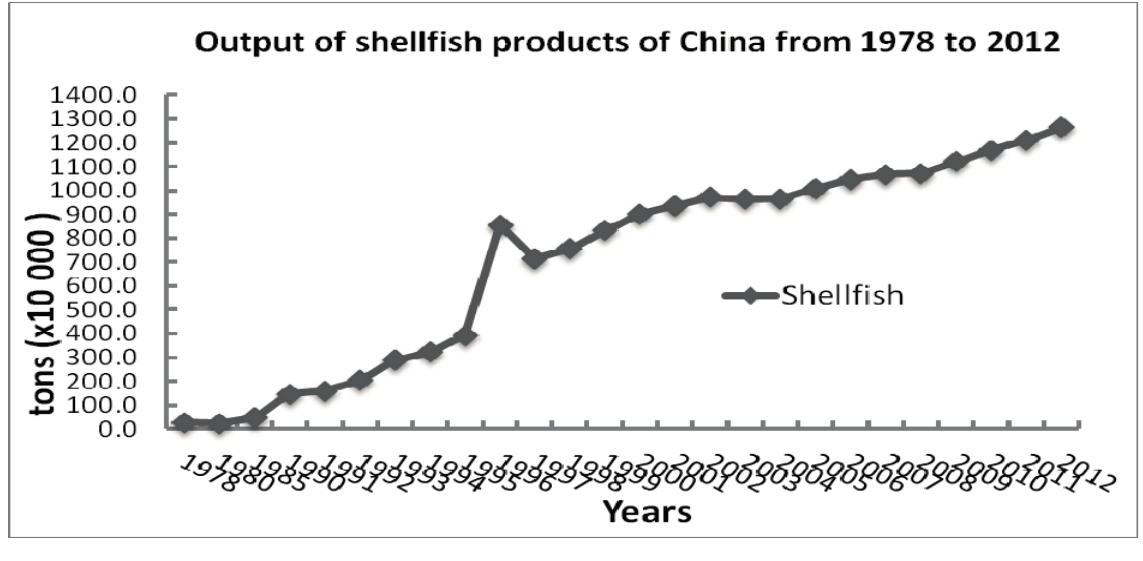
Figure A4. Output of shellfish products of China from 1978 to 2012. Source: China Statistical Yearbook 2013 (http://www.stats.gov.cn/tjsj/ndsj/2013/html/Z1320e.htm).